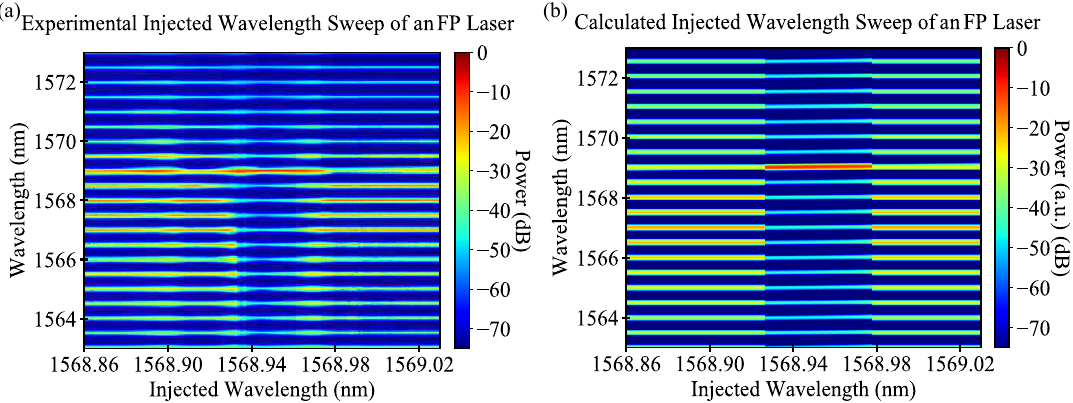
Figure 4. Experimental and calculated injected wavelength sweeps of a 700- µ m FP device. In both cases, the slave laser was biased at 2.5-times the threshold. ( a ) Experimental sweep, for an injected power of − 12.5 dBm and free running slave power of − 4 dBm. ( b ) Calculated sweep, for an injection ratio of 1.33 × 10 − 3